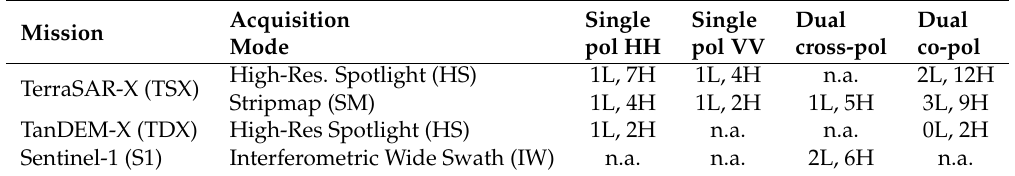
Table 1. SAR data collection according to acquisition mode, polarization and incidence angles (low angles “L”, high angles